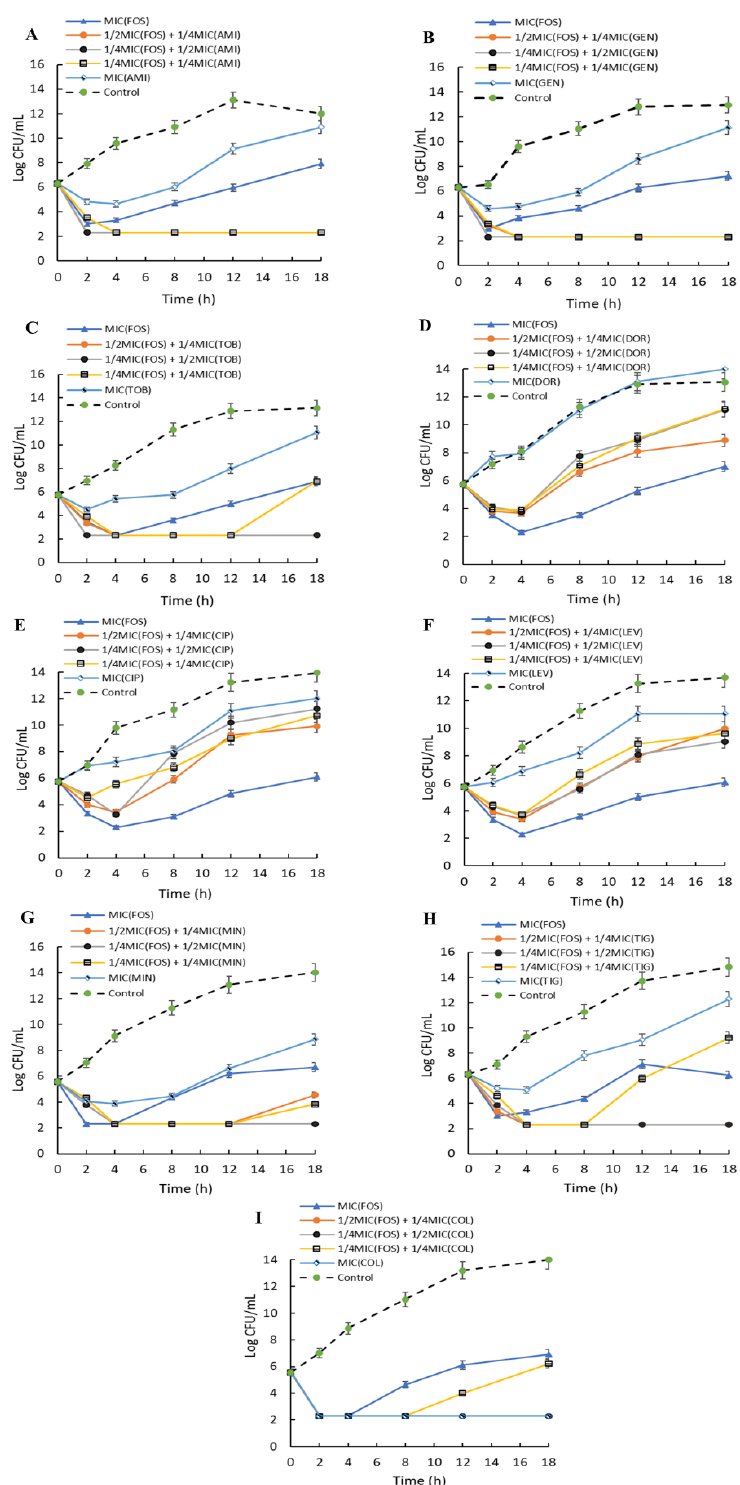
Figure 4. Time-kill curve of fosfomycin combinations against multi-drug-resistant (MDR) clinical isolates of Acinetobacter baumannii. ( A ) Fosfomycin and amikacin, ( B ) Fosfomycin and gentamicin, ( C ) Fosfomycin and tobramycin, ( D ) Fosfomycin and doripenem, ( E ) Fosfomycin and ciprofloxacin, ( F ) Fosfomycin and levofloxacin, ( G ) Fosfomycin and minocycline, ( H ) Fosfomycin and tigecycline, and ( I ) Fosfomycin and colistin. The experiments were performed in triplicate and reported as CFU/mL.